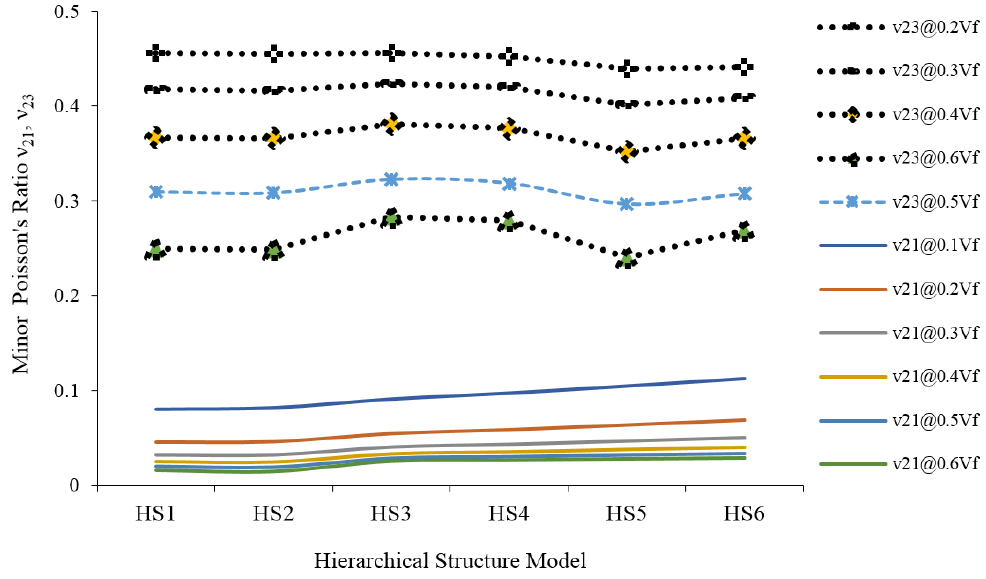
Figure 15. The minor Poisson’s ration ( ν 21 and ν 23 ) of jute fiber reinforced composites. Currently, jute fiber is utilized in a variety of industries, such as textiles, vehicles, and even some load-bearing applications. In the automotive industry, bio-polymers and ad- vanced composites made from jute are used for manufacturing parts like cup holders, trunk liners, and door panels [45–47].